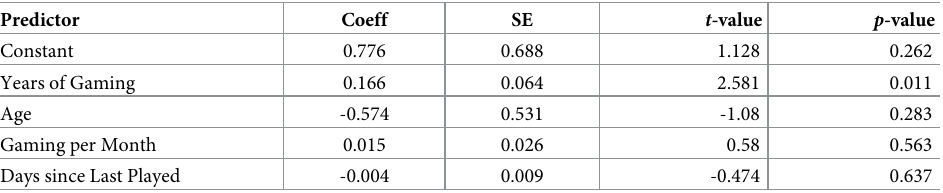
Table 8. Experiment 2: Multiple regression of participant response predicted by gaming experience. Predictor Coeff SE t- value